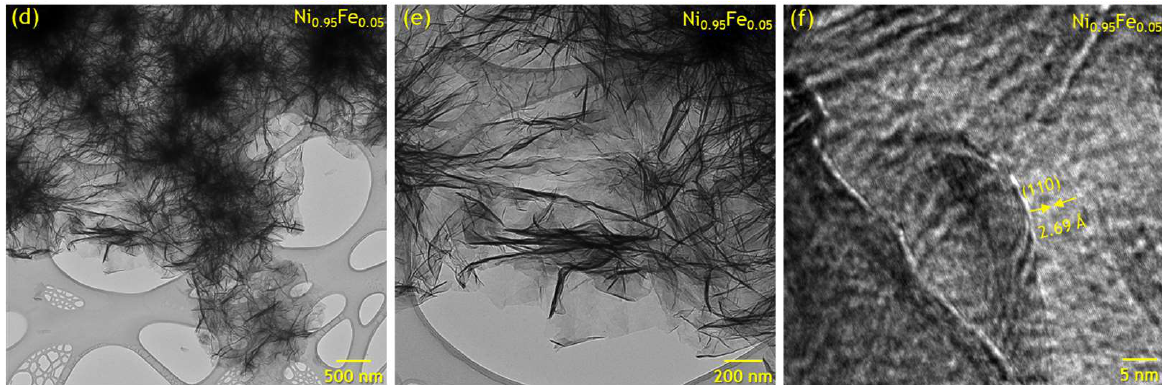
Figure 4. Bright-field transmission electron microscopy of Ni 1.00 Fe 0.00 ( a – c ) and Ni 0.95 Fe 0.05 ( d – f ) at different magnifications; the red box in ( b ) denotes the region used for the higher magnification image shown in ( c ); yellow dotted circles in ( c ) show crystalline domains with the (110) planes oriented perpendicular to the yellow arrows.